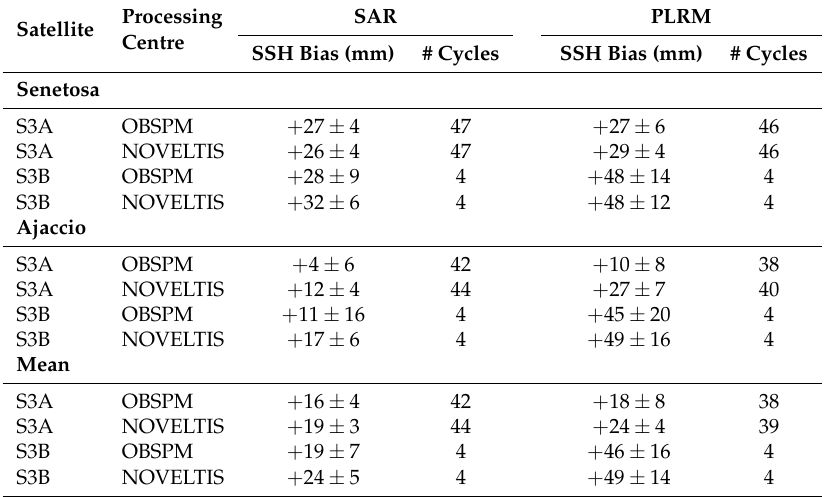
Table 3. Statistics on the Sentinel-3A and Sentinel-3B SAR and PLRM absolute SSH bias estimates in Corsica (track